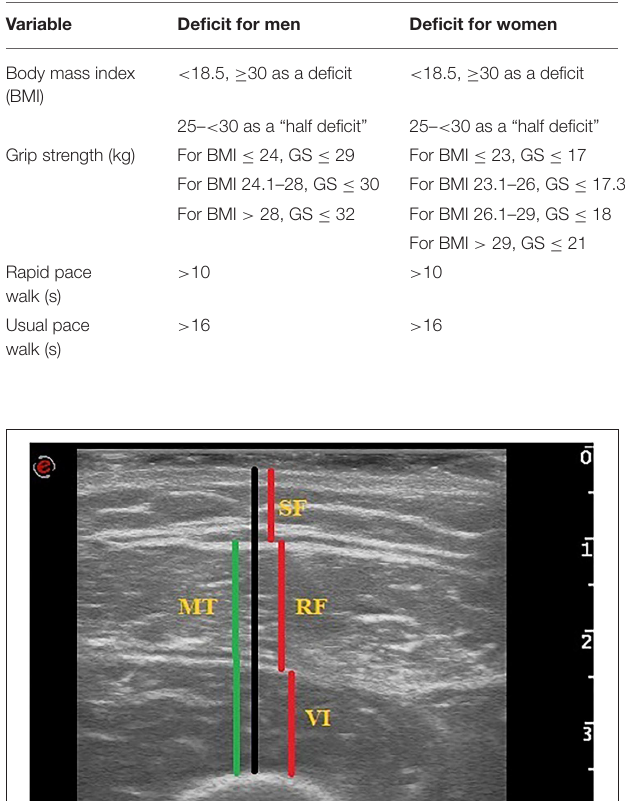
TABLE 2 | Deficit cut-off values for continuous variables by sex – adapted from (9).